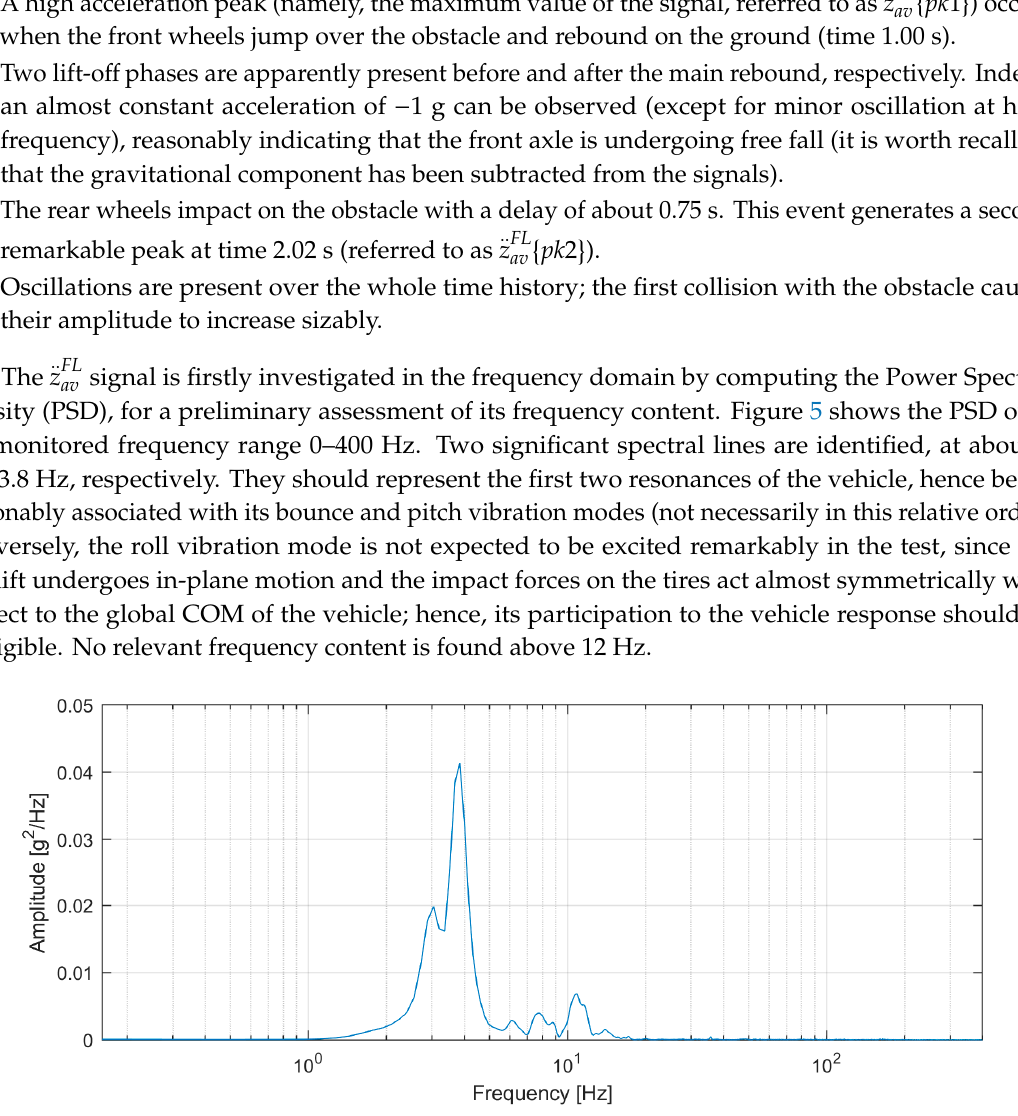
Figure 5. PSD of the